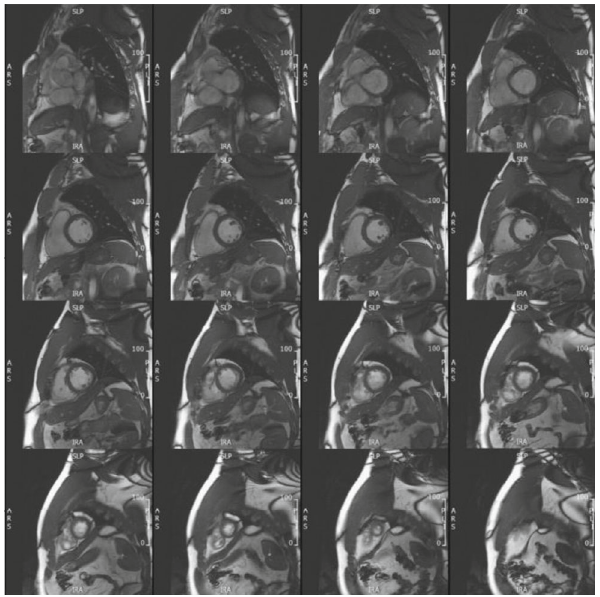
Figure 1: Conventional cine acquisition. A stack of short-axis slices covering the heart from base (top left) to apex (bottom right), obtained using conventional 2D cine acquisition, where each slice is acquired in a separate breath-hold. Totalscan time ð including recovery timein − betweenconsecutivebreath − holds Þ = 270s